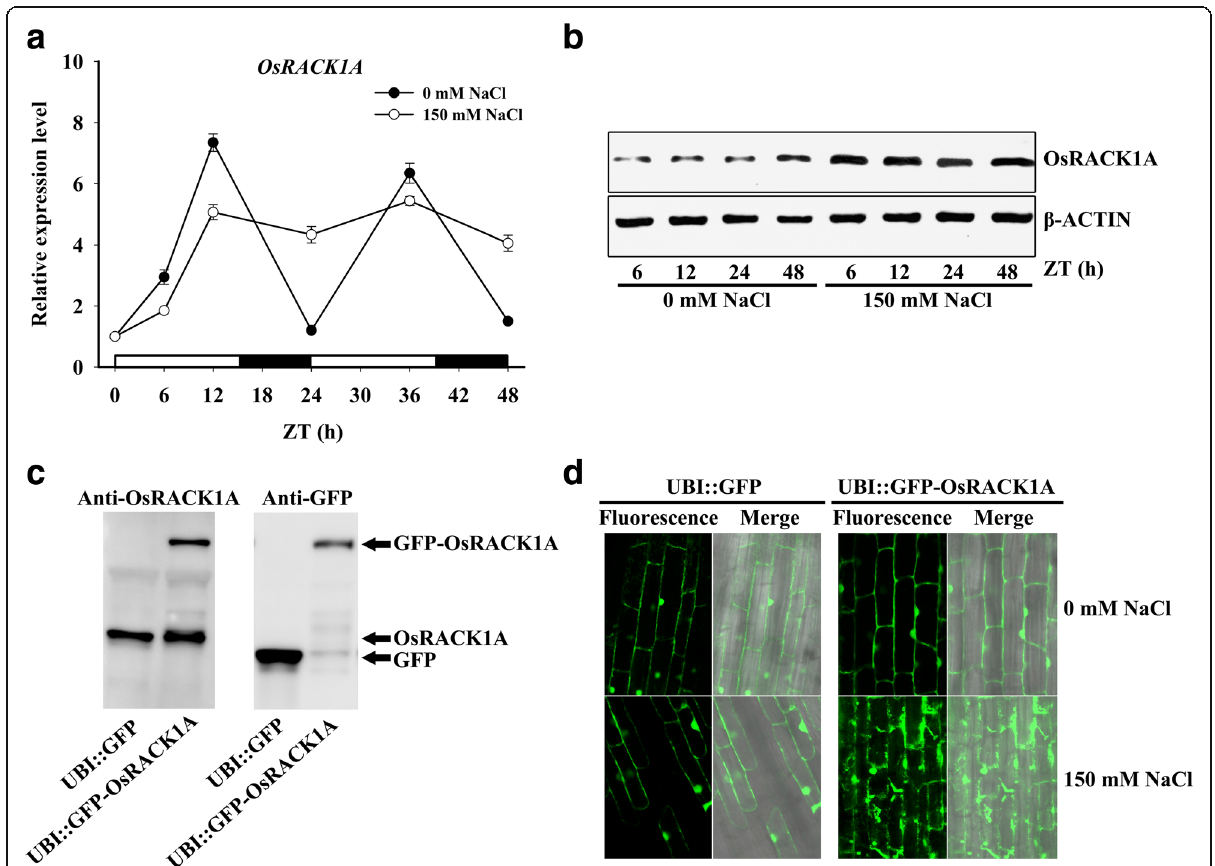
Fig. 2 Salt stress-controlled OsRACK1A expression in rice. a Transcript analysis of the OsRACK1A gene by qRT-PCR for a 48-h period under 0 and 150 mM NaCl treatment. b Immunoblot analysis of OsRACK1A protein for a 24-h period under 0 and 150 mM NaCl treatment. c GFP, OsRACK1A and a GFP-OsRACK1A fusion protein were monitored by immunoblot analysis in seedlings of UBI -promoted GFP and GFP-OsRACK1A transgenic rice. d GFP fluorescence was examined in roots of UBI -promoted GFP and GFP-OsRACK1A transgenic rice under 0 and 150 mM NaCl treatment for 6 h. ZT, Zeitgeber Time. White and black rectangles indicate lights on and lights off,